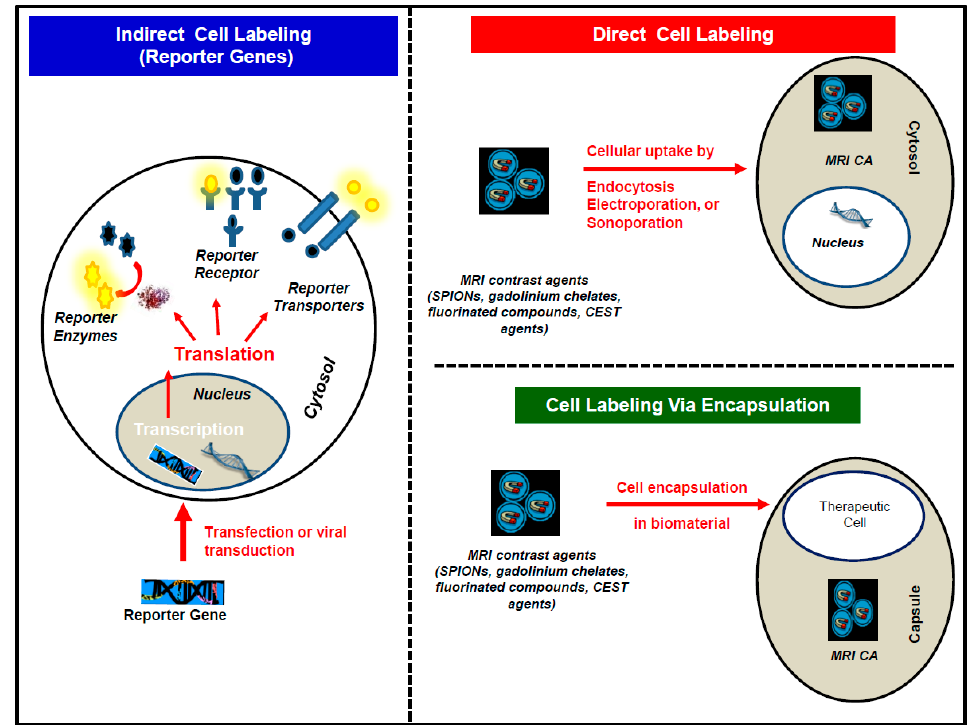
Figure 3. Schematic representing the different cell labeling approaches. Where, CA stands for contrast agents; CEST stands for chemical exchange saturation transfer; and SPIONs stands for superparamagnetic iron oxide nanoparticles.